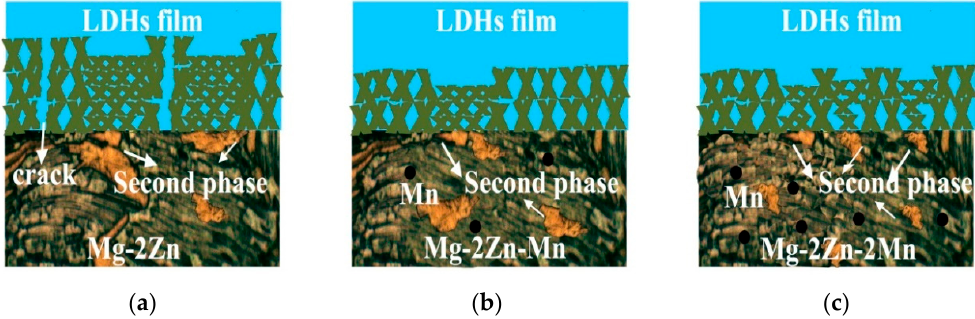
Figure 9. Schematic illustrating the growth mechanism of the Mg–Al LDHs films on Mg alloys with different alloy microstructures.